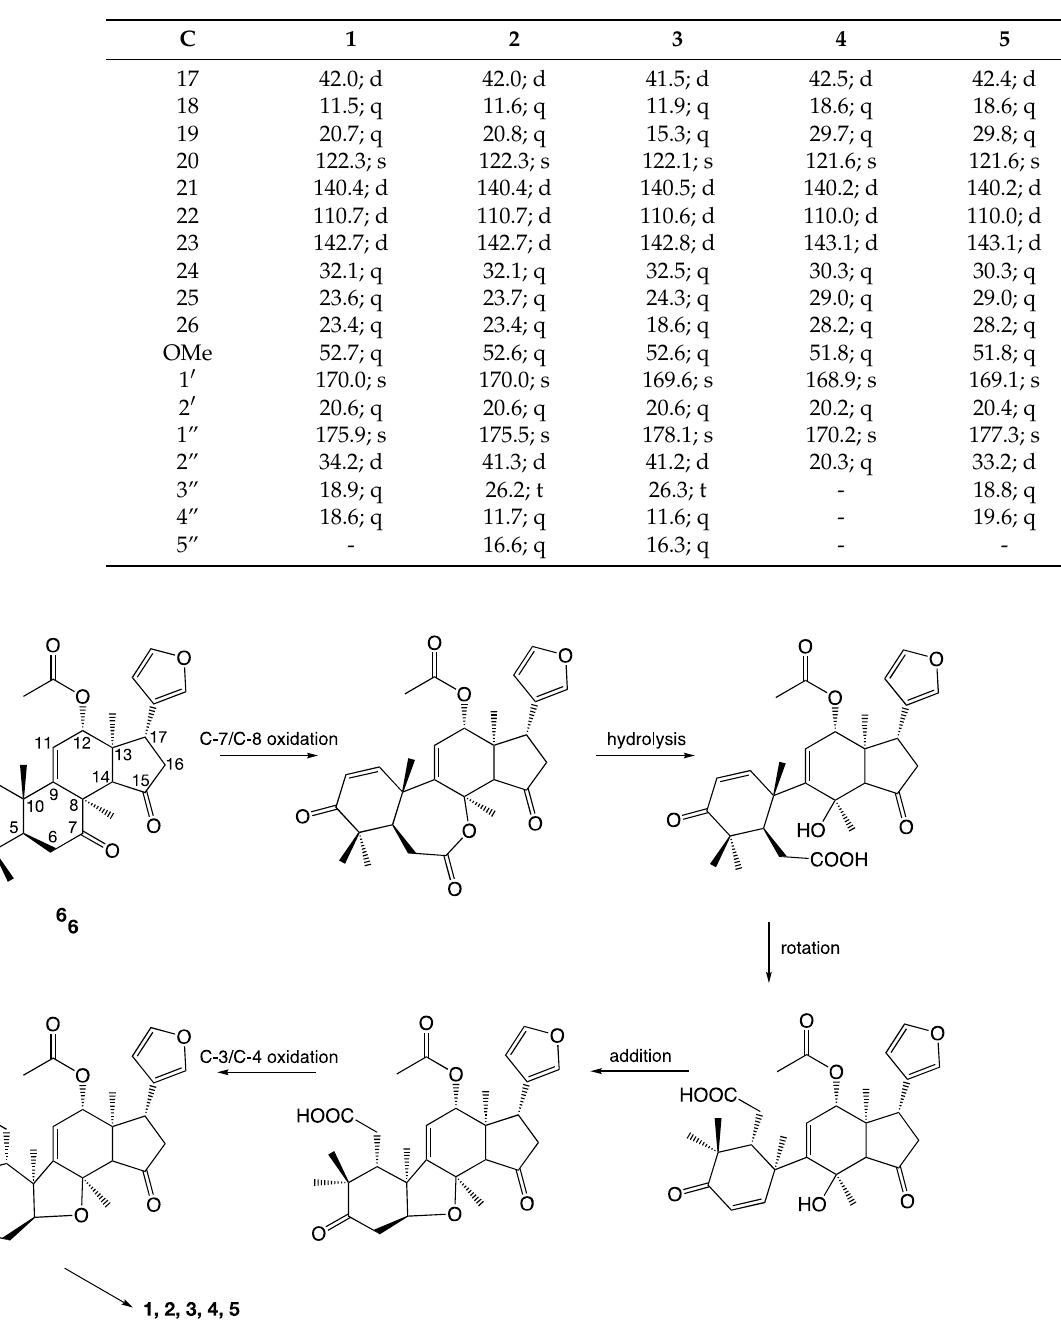
Table 3. Leishmanicidal activity against leishmanial promastigotes (L.a: Leishmania amazonensis ; L.b.: L. braziliensis ) and cytotoxicity in murine macrophage cells (Raw 264.7 cells ), of compounds